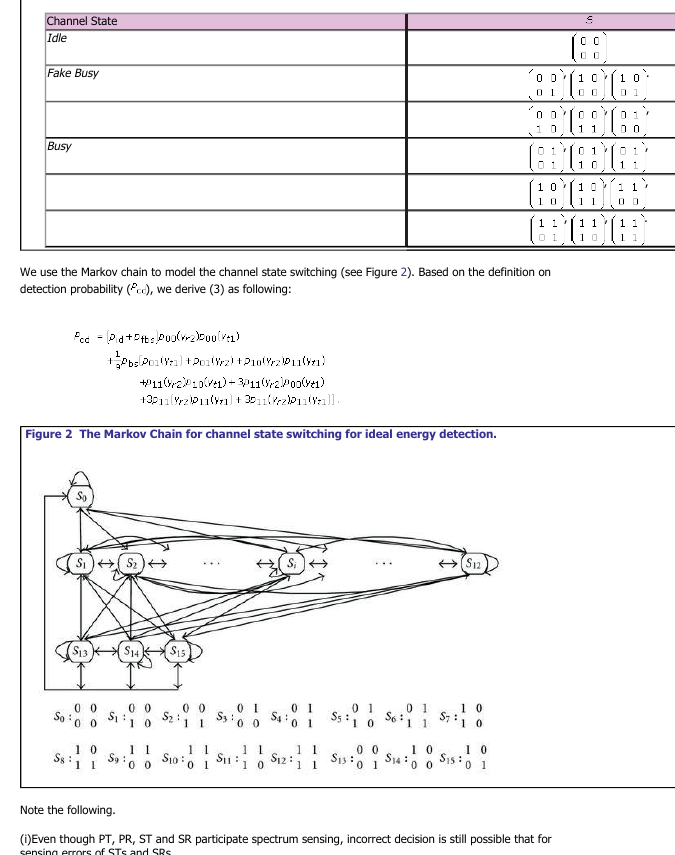
Table 1 Channel state classification according to for ideal energy detection.